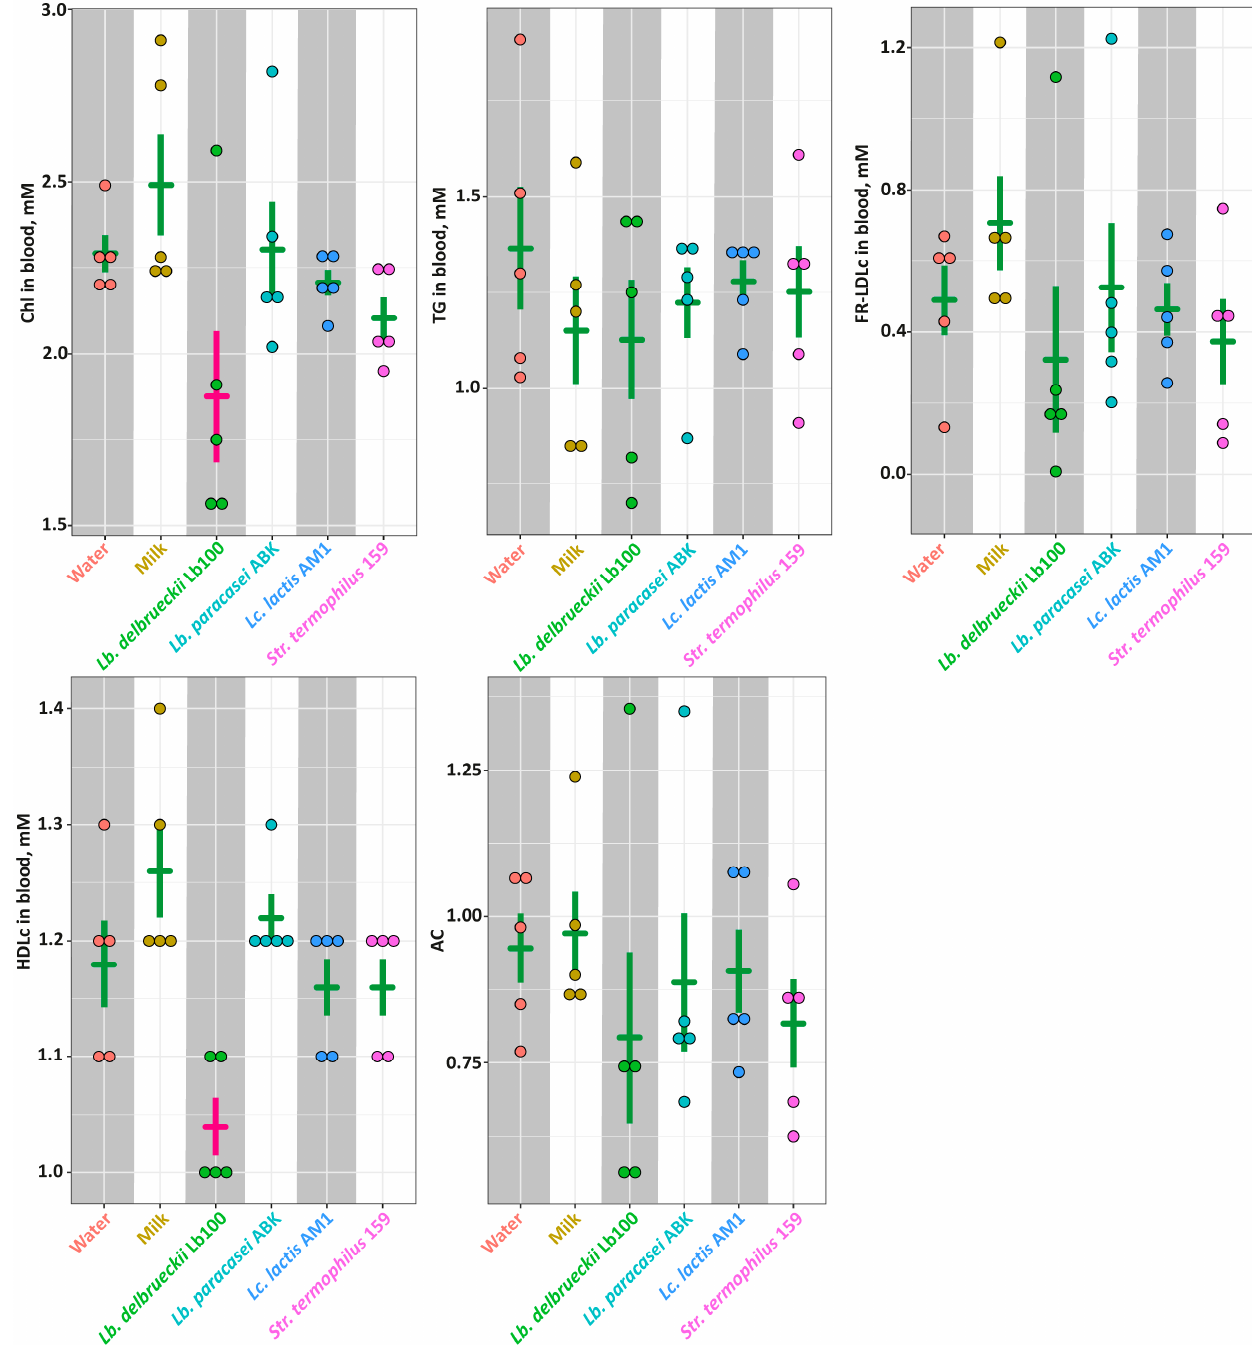
Figure 5. The markers of the lipid metabolism for studied animal groups. The bars (Mean ± SE) for the groups between which no statistically-significant differences were detected are depicted in the same color.